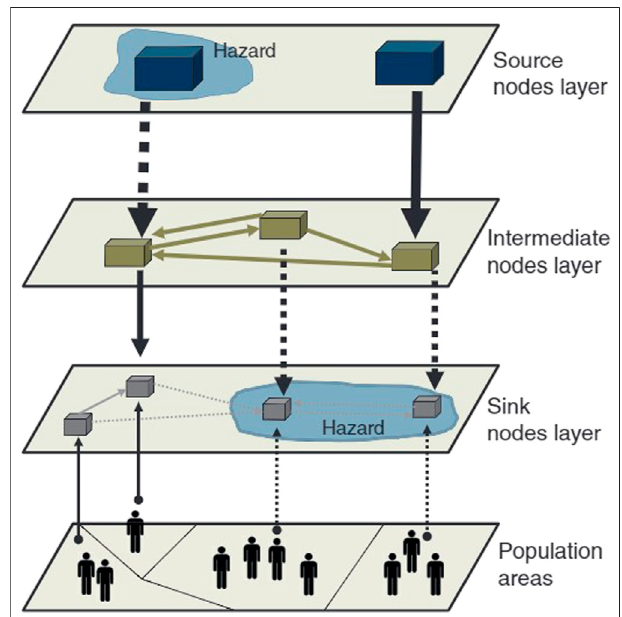
FIGURE 2 | Representation of network demand (modi fi ed from Pant et al.,